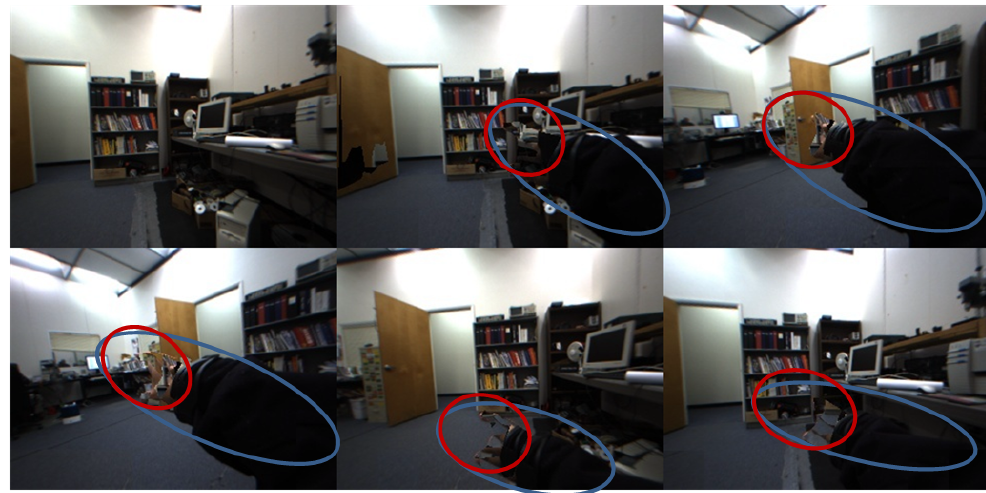
Figure 2. Examples of hand detection with our background subtraction under dynamic scenes: a pointing finger (red) and a moving arm (blue). Note that images were taken sequentially from left to